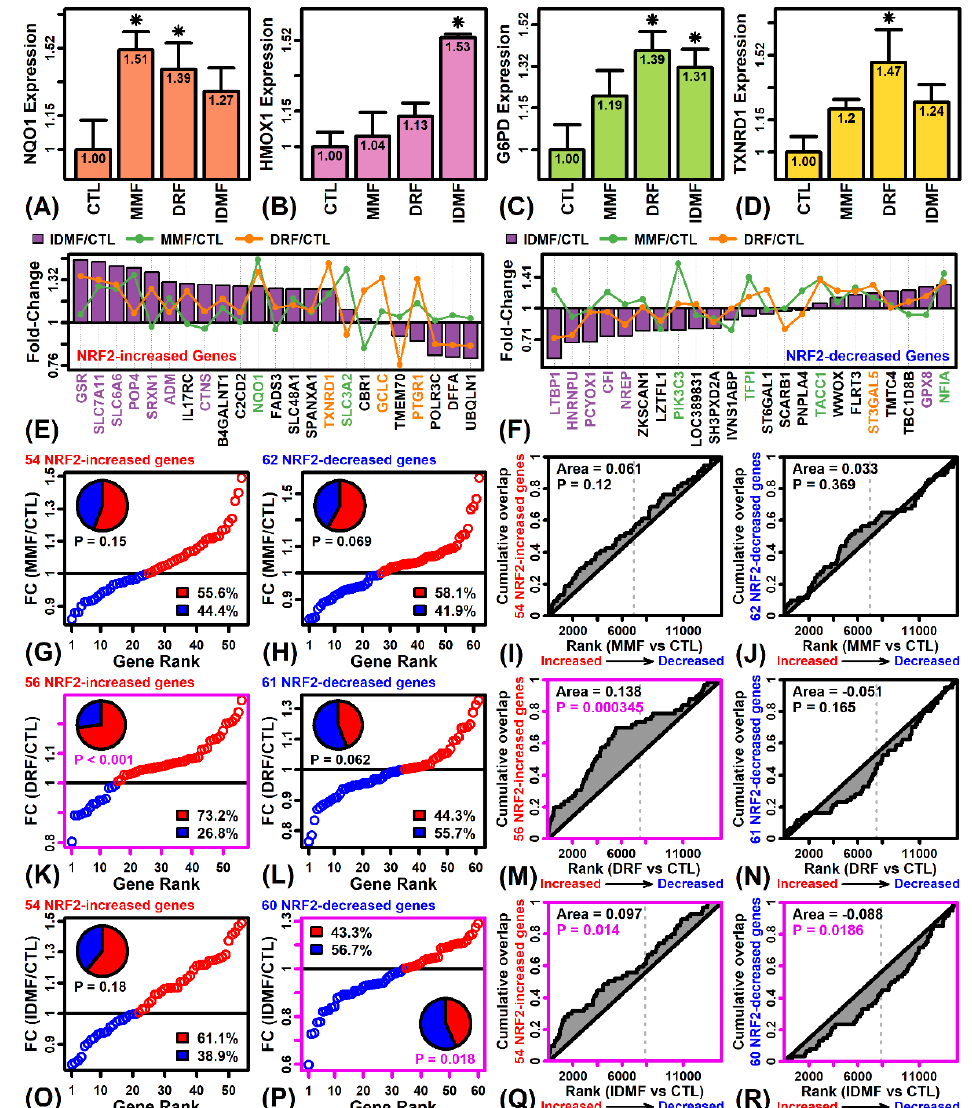
Figure 4. NRF2 target genes. ( A ) NQO1 . ( B ) HMOX1 . ( C ) G6PD . ( D ) TXNRD1 . In ( A – D ), average expression (log 2 scale) is shown for each treatment (± 1 standard error; * p < 0.05, comparison to CTL treatment). Expression is normalized to the average value in the CTL treatment for each gene. ( E ) NRF2-increased genes. ( F ) NRF2-decreased genes. In ( E , F ), the value of |FC| max was calculated for each gene, where |FC| max is defined as max [abs(FC MMF , FC DRF , FC IDMF )], and the 23 NRF2-increased or NRF2-decreased genes with highest value of |FC| max are shown. Non- black gene labels are used if there is significant differential expression ( p < 0.05) for any of the three comparisons, in which case the label color matches the comparison associated with the lowest differential expression p -value. ( G , H , K , L , O , P ) FC estimates for NRF2-responsive genes. FC estimates are plotted and the proportion of fumarate-increased (red) fumarate-decreased (blue) genes is shown ( p -value: Fisher’s exact test). The percentage of increased/decreased genes is also indicated (see legend). ( I , J , M , N , Q , R ) The cumulate overlap is shown between NRF2-regulated genes and genes ranked based upon their response to each fumarate compound. A positive area statistic denotes enrichment among fumarate-increased genes, and a negative area statistic indicates enrichment among fumarate-decreased genes ( p -value: Wilcoxon rank sum